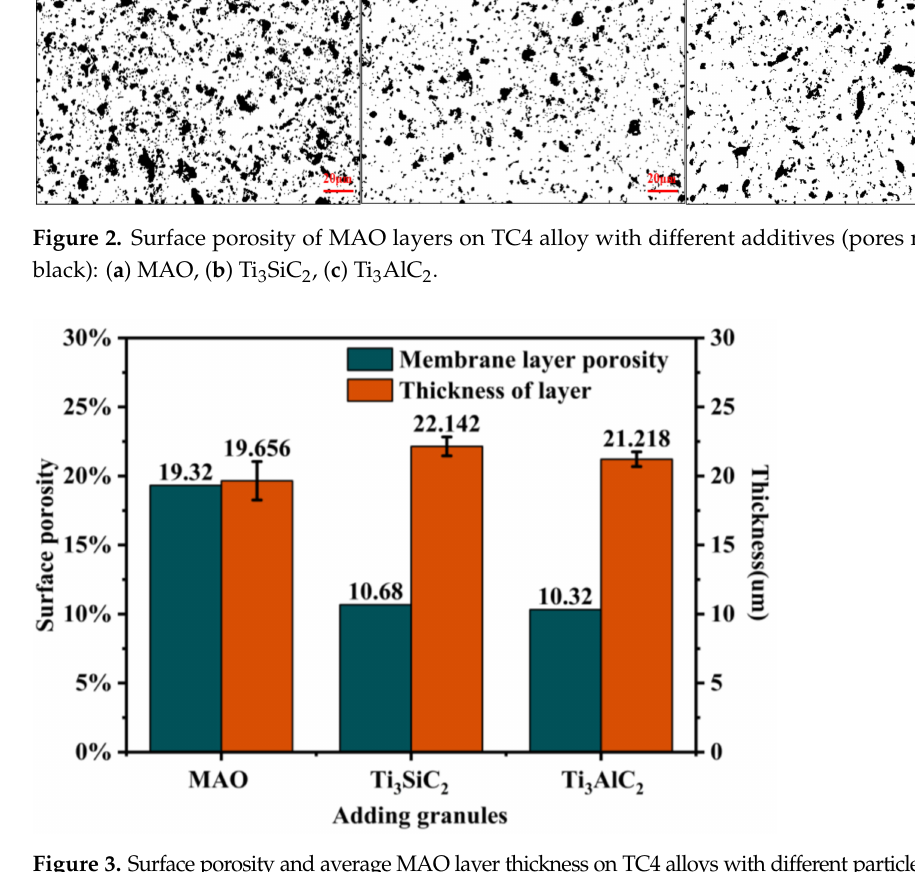
Figure 3. Surface porosity and average MAO layer thickness on TC4 alloys with different particle